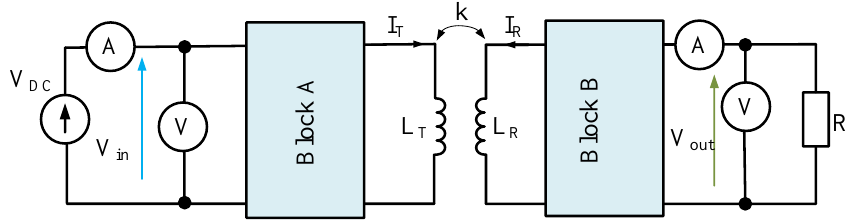
Figure 6. Setup for measuring WPT system properties.